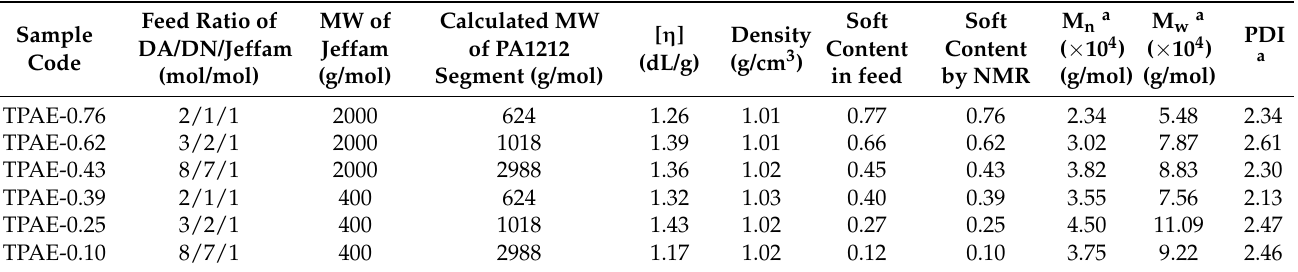
Figure 2. 1 H- 1 H COSY spectrum of TPAE-0.76. Table 1. Compositions, GPC results, [ η ], density of